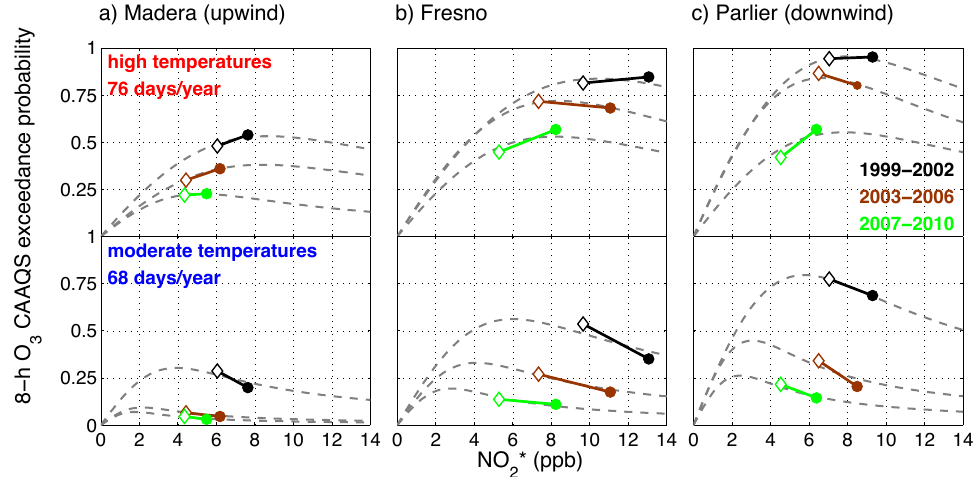
Fig. 8. Tethered four-year median weekday (closed circles) and weekend (open diamonds) 8-h O 3 CAAQS exceedance probabilities vs. NO 2 * in the Central SJV for 1999–2002 (black), 2003–2006 (brown), and 2007–2010 (green). Data are separated into high- (top) and moderate- (bottom) temperature regimes for Madera (a) , Fresno (b) , and Parlier (c) . Uncertainties in the probability of violations are computed with counting statistics, are typically less than ± 0.04 (1 σ) for weekdays and ± 0.06 (1 σ) for weekends. Curves (dashed grey lines) were produced with an analytical model as for Fig. 6 .